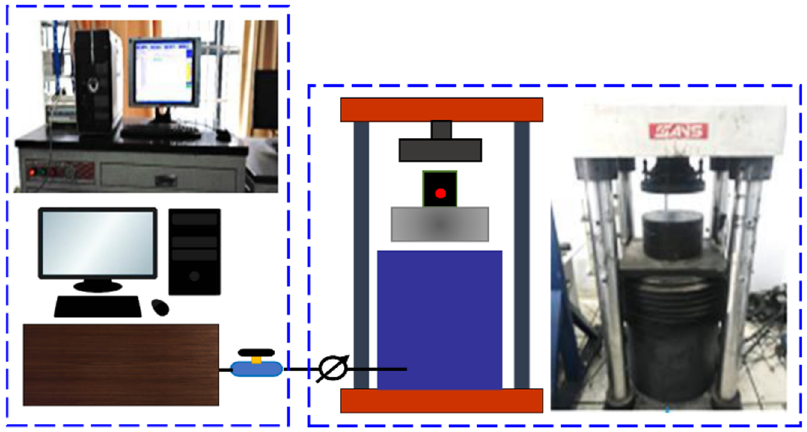
Figure 3. Schematic loading system with equipment photos.